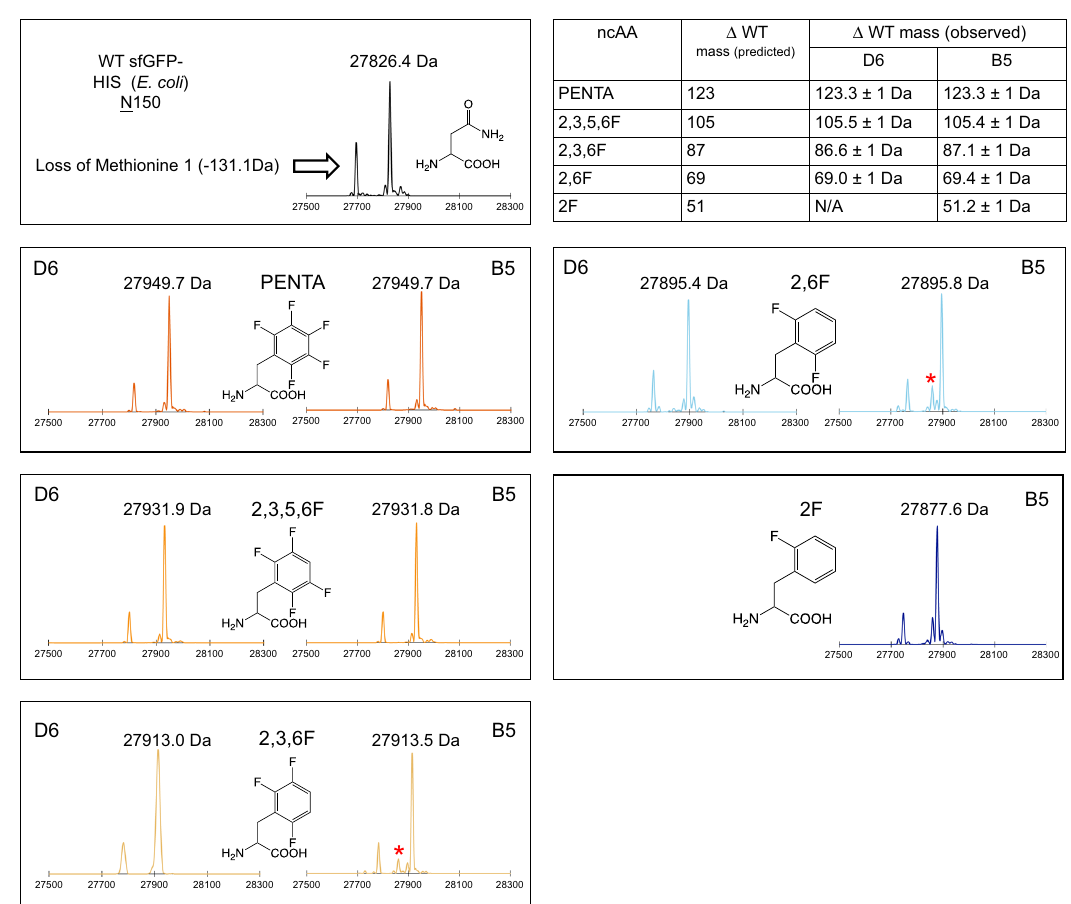
fl uoro Phe species. In some conditions for B5 synthetase, a small fraction of mass consistentwithPheincorporationwasobserved(asterisks).Massspectrometrywas not pursued for the combination of 2F Phe and D6 due to low expression in the